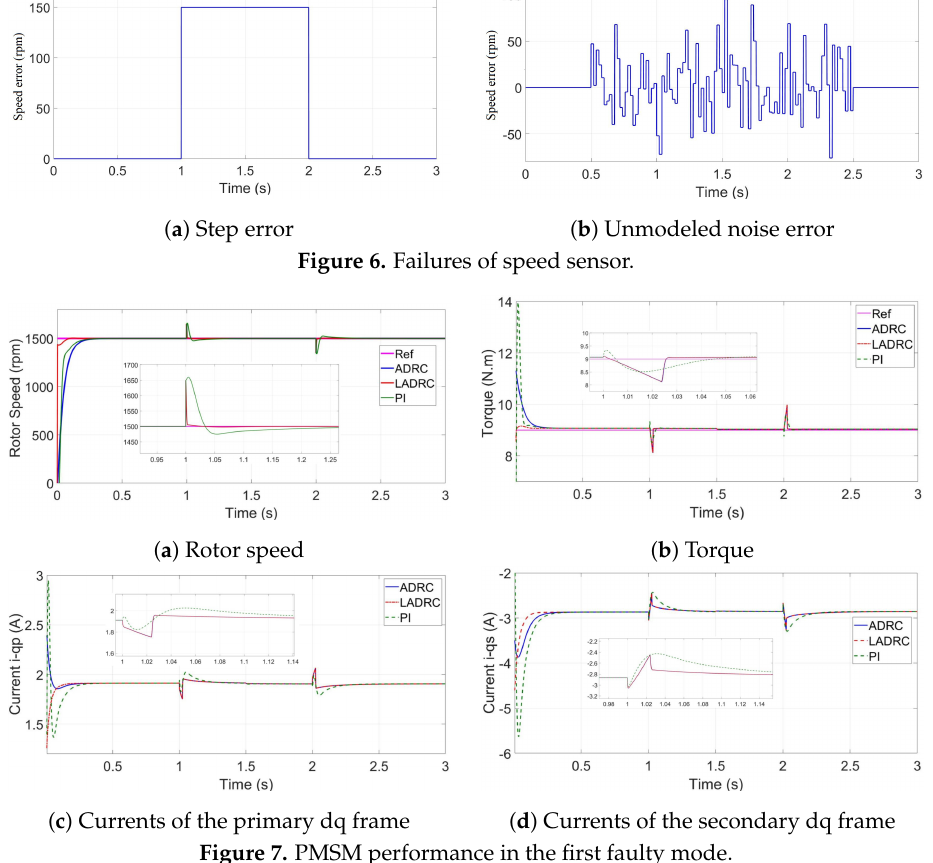
Figure 7. PMSM performance in the first faulty